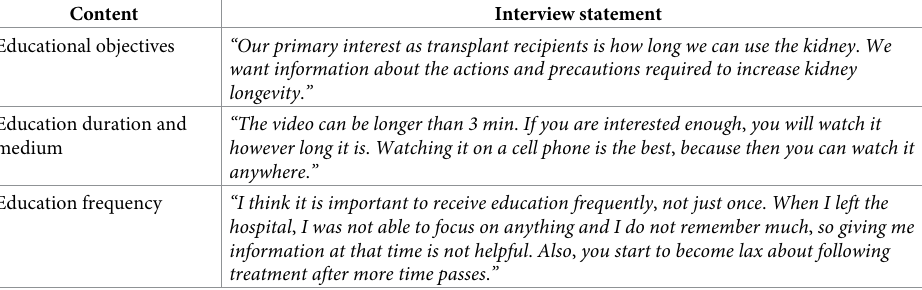
Table 2. Patient interview results (educational objectives and methods).